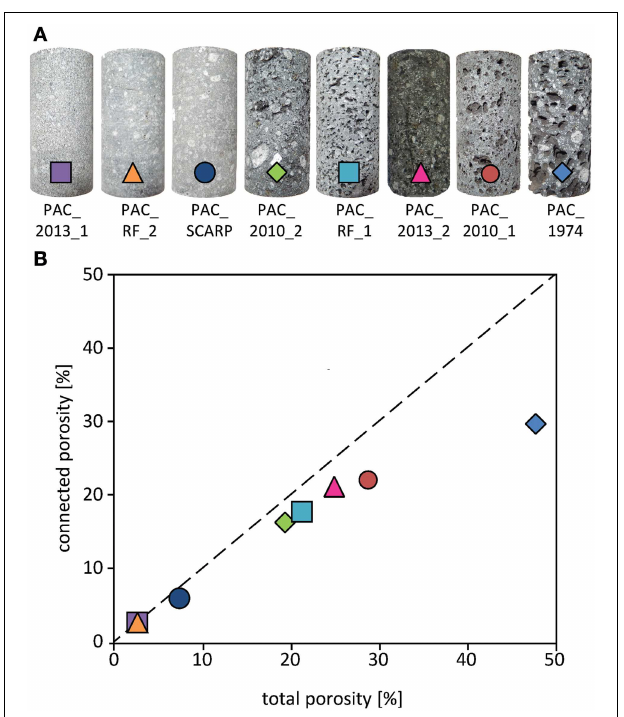
FIGURE 3 | (A) Photographs of the samples selected for this study and (B) Porosity of the samples as determined by helium pycnometry. The figure displays the fraction of connected pores against the total porosity of the samples.